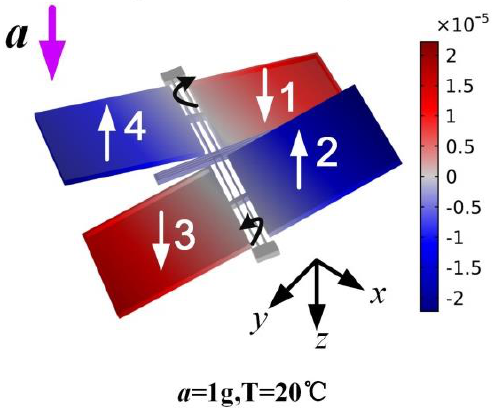
Figure 2. FEM simulation when 1 g acceleration is applied along the sensing direction, the positive z direction, at room temperature. The color shows the displacement of the silicon structure compared with the initial position along the sensing direction ( z direction).